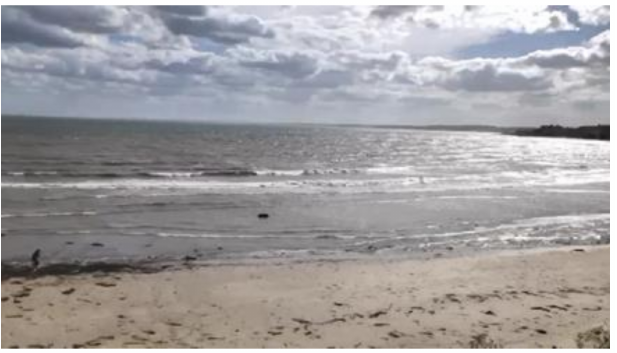
Figure 2. “ This week has been nice calm and relaxing. We went to see my uncle and to the beach hut to get fish and chips ”—Female, Aged 13, Diary Extract, 21 August